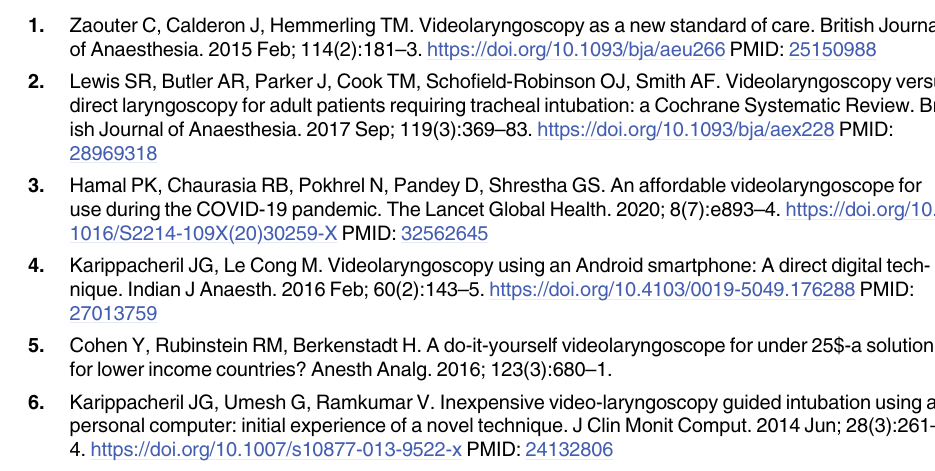
S1 Table. PRISMA guideline checklist. S2 Table. Search strategies of the included studies. S3 Table. AMSTAR-2 rating